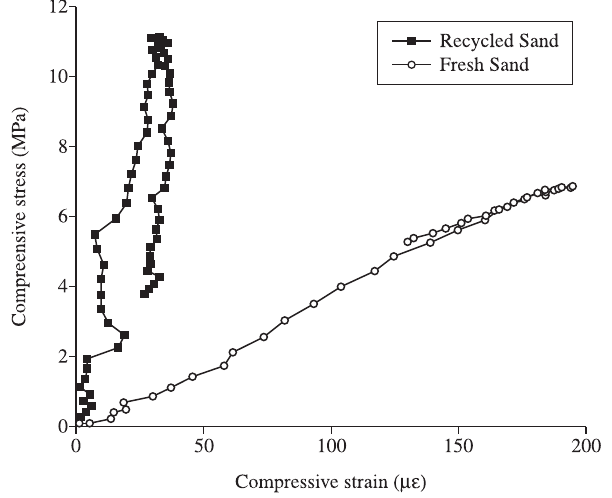
Figure 4. Compression test monitoring using FBG sensors embedded in polymer concrete.